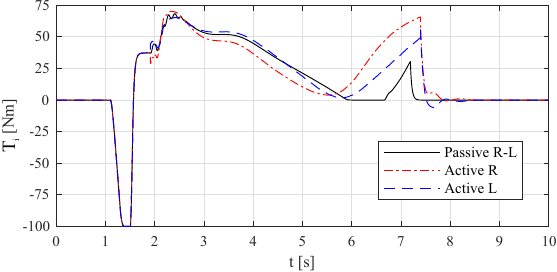
Figure 11. U-turn, highly skilled driver, motors’